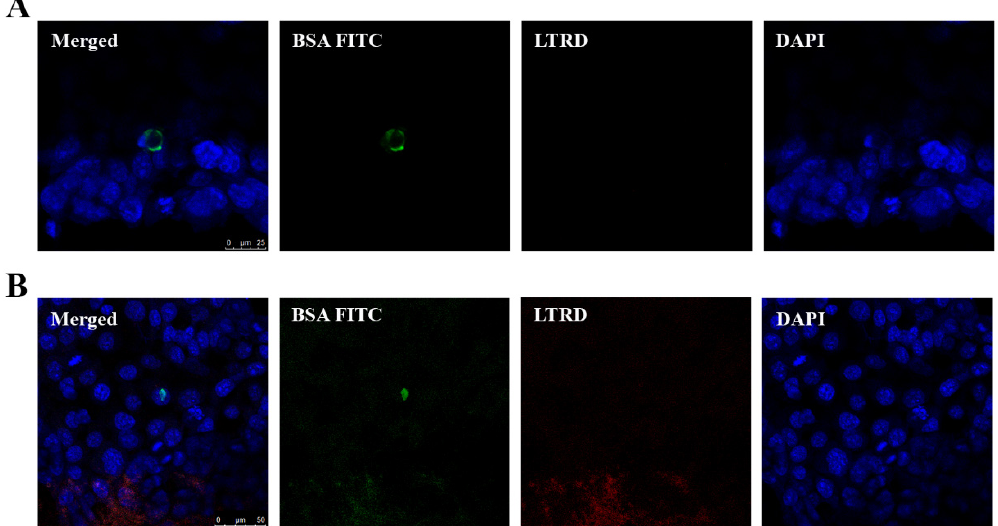
Figure 7. Uptake of EVs containing BSA FITC by FaDu cells. FaDu cells were co-cultured with EVs containing BSA FITC (undiluted). After 4 h, cells were washed with acid wash buffer followed by PBS and fixed prior to staining. LTRD probe (red) was used to stain lysosome and DAPI (blue) to stain the nucleus. Merged images show the uptake of BSA FITC by FaDu cells. BSA FITC signal (green) seems to be present in the cell cytoplasm ( A , merged ) or in the vicinity of the cell nucleus ( B , merged